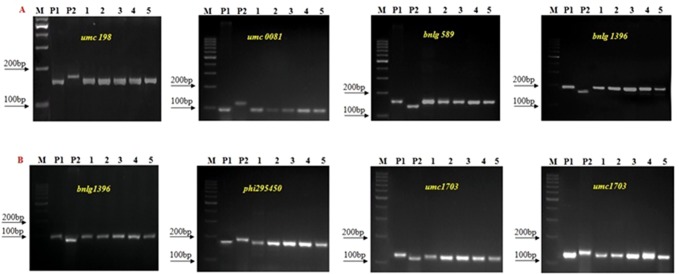
Background Screening of improved lines using SSR makers. (A) 1200β+xHKI163, (B) UMI1230β+xHKI163. (M) Marker 100bp, (P1) UMI 1200β+/UMI 1230β+, (P2) HKI163, (1-5) Improved lines from 1200β+xHKI163 (1-DBT6-1-5/25-8/25-4/25-4/25, 2-DBT6-1-5/25-8/25-9/25-9/25, 3- DBT6-1 5/25-10/25-15/25-15/25, 4-DBT6-1-5/25-10/25-17/25-17/25, 5- DBT6-1-5/25-14/25-11/25-11/-25) and 1230β+xHKI163(1- DBT7-1-6/25-9/25-37/25-37/25, 2-DBT6-1-6/25-9/25-57/25-57/25, 3- DBT7-1-6/25-12/25-23/25-23/25, 4- DBT7-1-6/24-27/25-3/25-3/25, 5-DBT7-1-6/25-27/25-67/25-67/25).